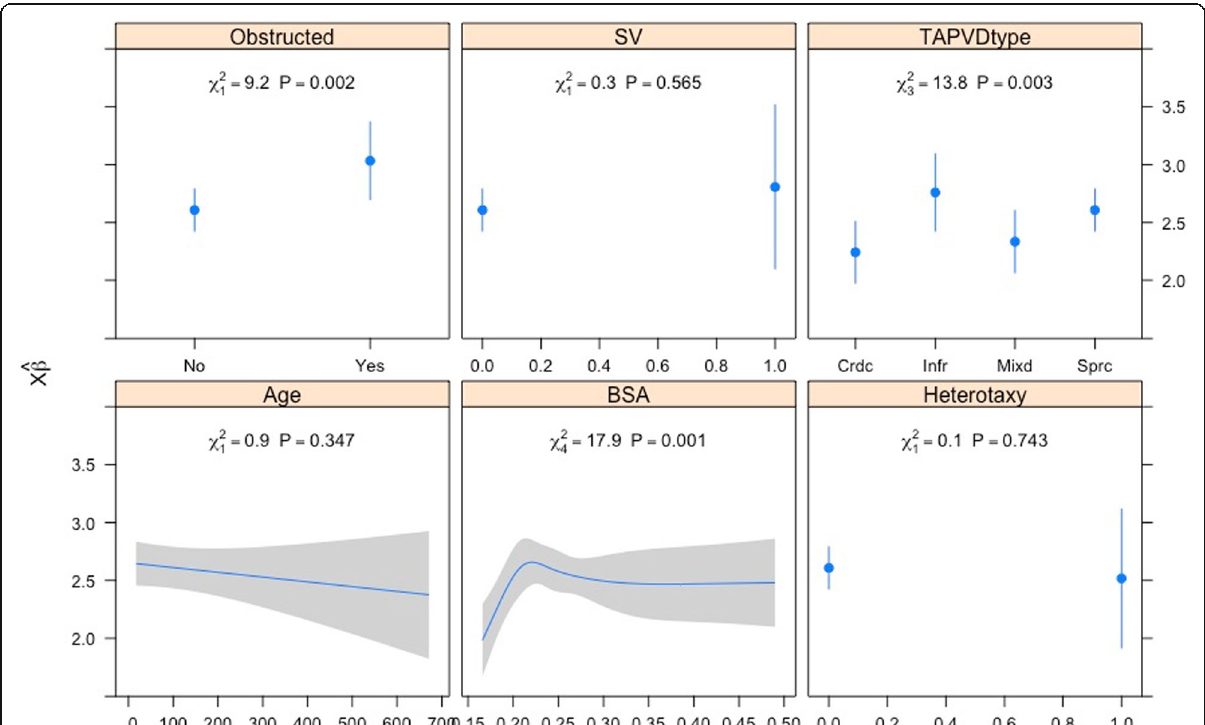
Fig. 4 Predictors of postoperative length of stay using a generalized linear model with Poisson distribution. Test shown is Wald statistic of model analysis of variance. SV: single ventricle anomalies, TAPVDtype: anatomical TAPVD type, Crdc: cardiac TAPVD, Infr: infracardiac TAPVD, Mixd: mixed TAPVD, Sprc: supracardiac TAPVD, BSA: body surface